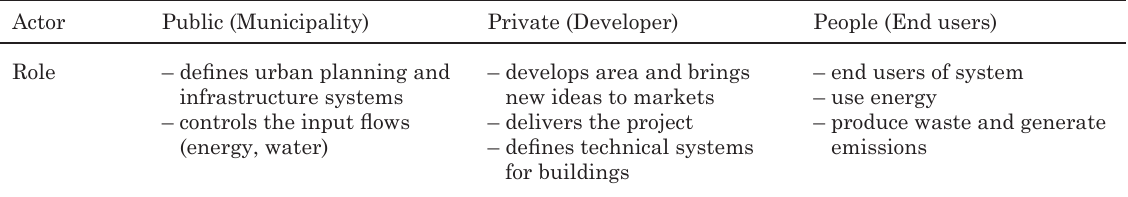
table 1. Actors and their roles in the urban planning process